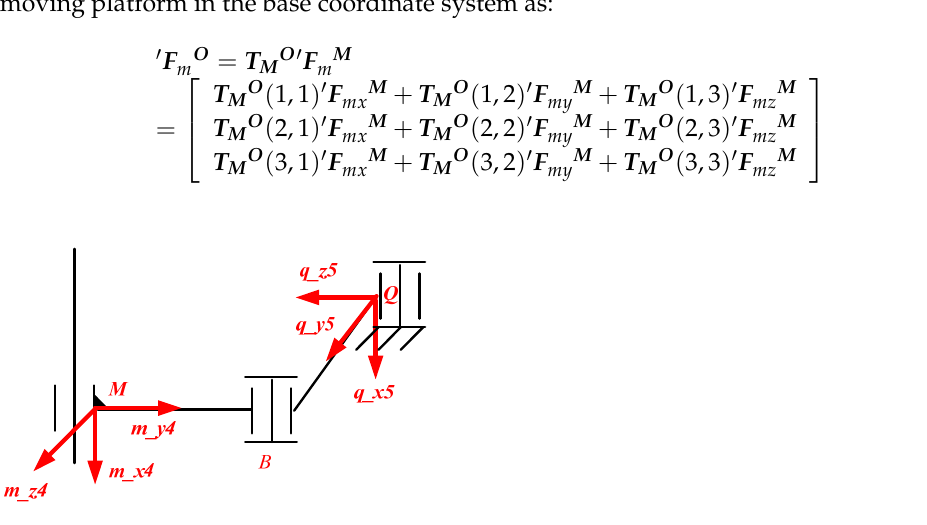
Figure 9. Coordinate system of bottom kinematic chain 2.